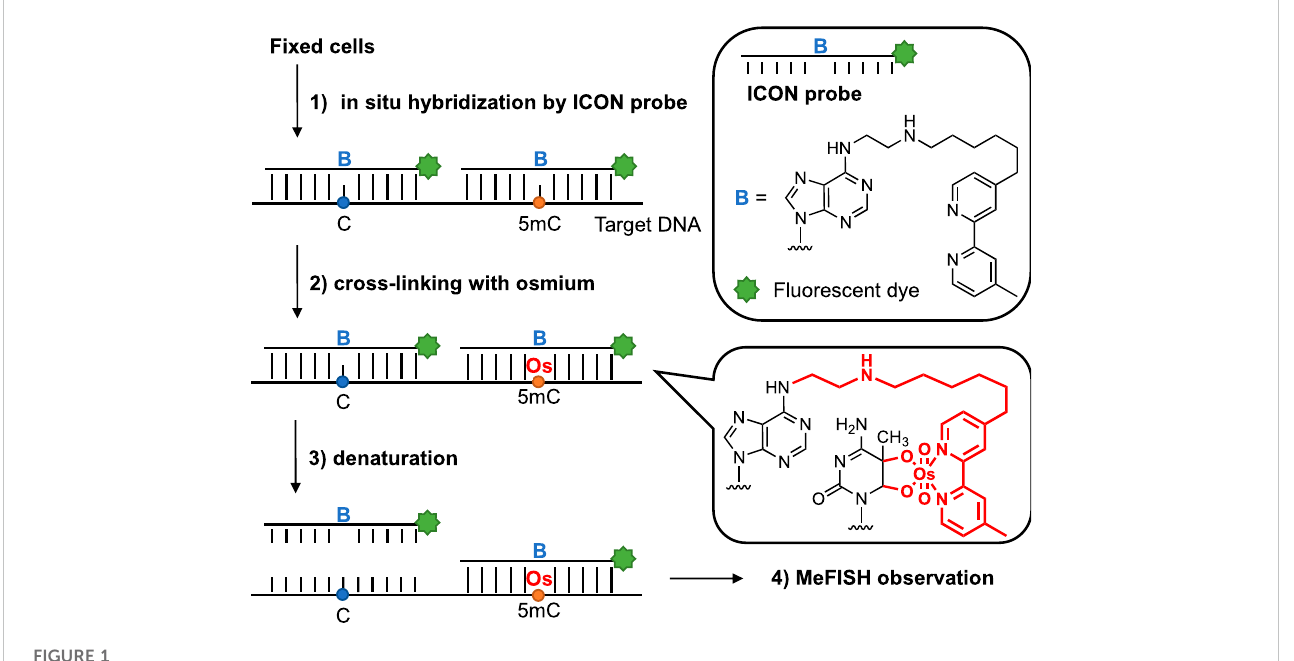
FIGURE 1 Sequence-speci fi c 5 mC detection in DNA using ICON probes.